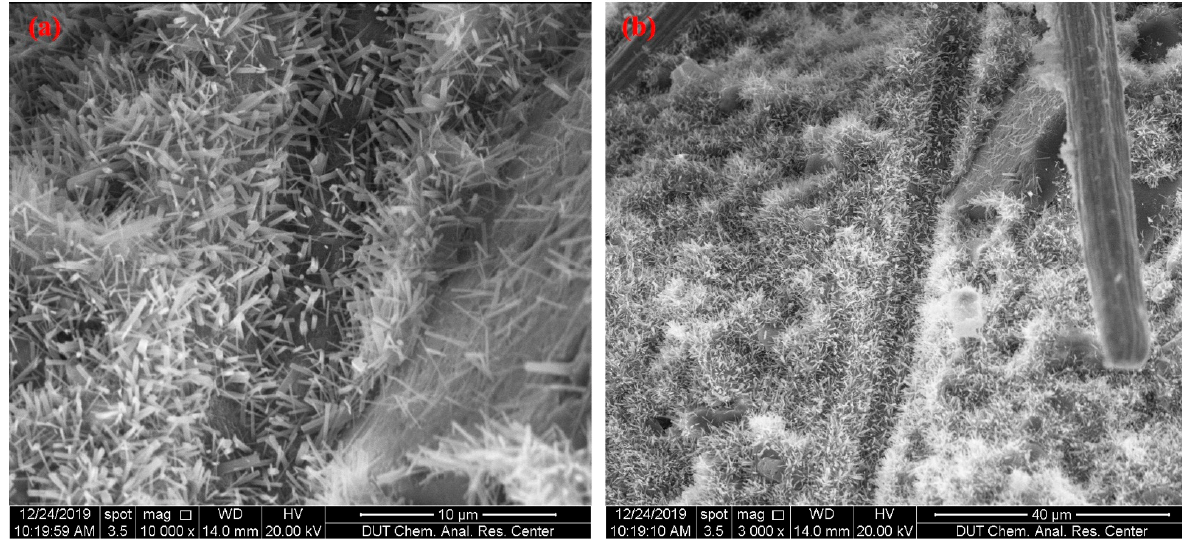
Figure 11. Morphology of FRC after sulfate attack.